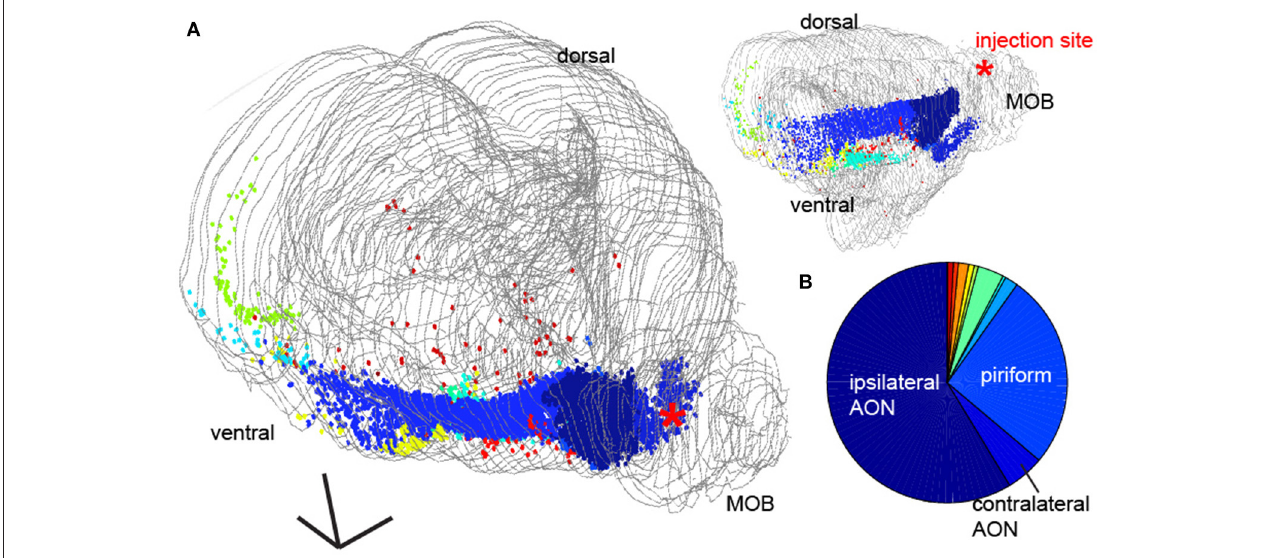
FIGURE 5 | Area identity of feedback projections to the main olfactory bulb. (A) Whole brain 3D reconstruction (gray lines correspond to tissue edge for each coronal section) from 2 perspectives with fluorescently labeled neurons in different brain regions represented as points. Scale bar = 500 um. (B) Pie chart of the distribution of cells in different brain areas from the 3D reconstruction The three largest sources of feedback are